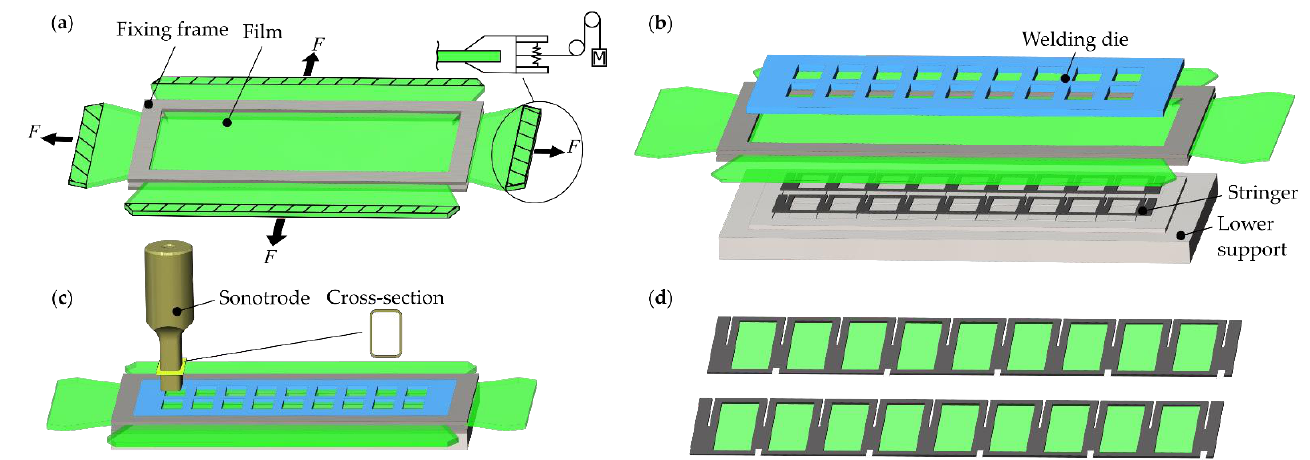
Figure 15. ( a ) Process of pretension the film using a force-controlled set-up including clamps and weights and the subsequent conservation of the resulting stress state by applying a fixing frame, ( b ) necessary components for ultrasonic welding including welding die, lower support carrying the stringers and the pre-tensioned film, ( c ) rectangular sonotrode with its cross-section as well as the final setup for ultrasonic welding of the film and the stringer, ( d ) stringers with attached films. After removing the excess film material, the curved frame and the stringers are assembled. Finally, the cover layer and the perforated cover sheet are adhesively bonded to the cavity structure (see Figure 16).